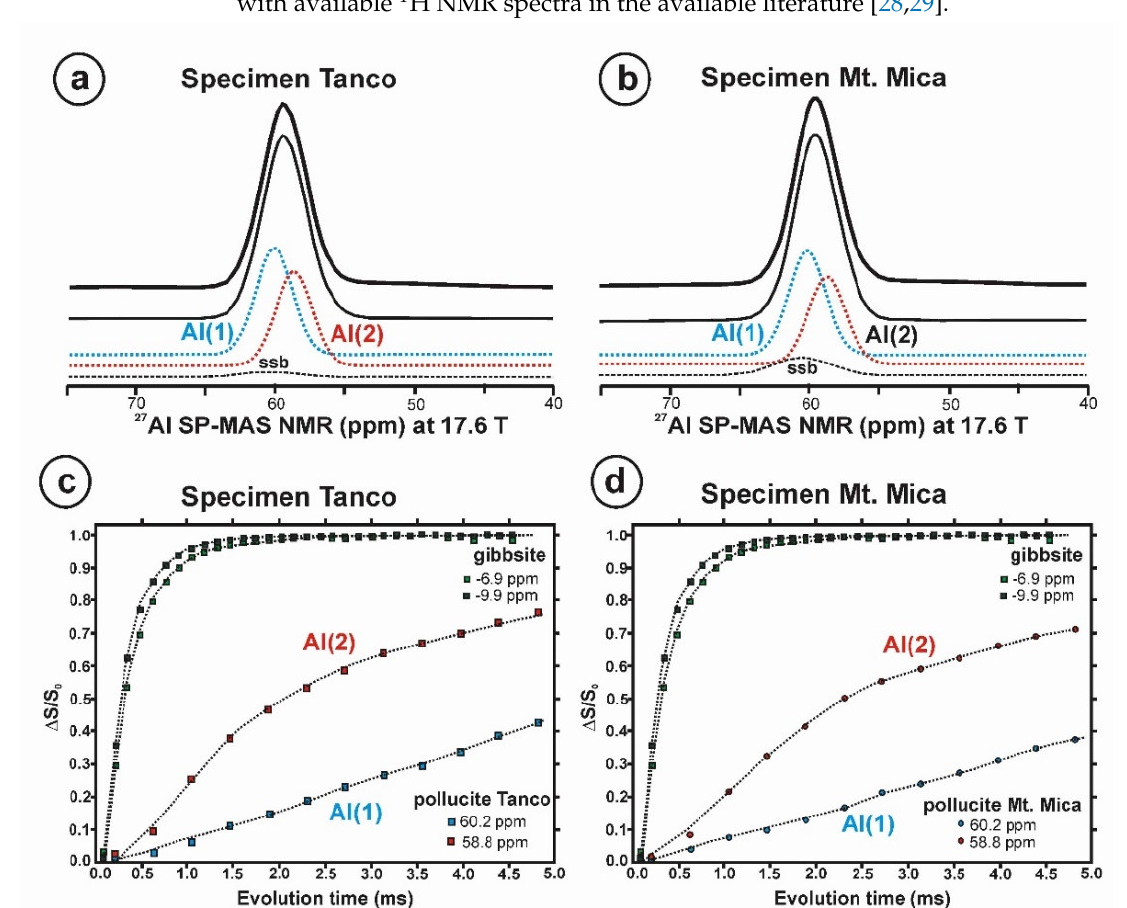
Figure 6. ( a , b ) Single pulse 27 Al spectra of the specimens Tanco and Mt. Mica at 17.6 T, showing a deconvolution of the experimental profile by two Gaussian curves at 60.2 ppm and 58.8 ppm, in addition to the spinning side band from the 3/2 transition. ( c , d ) 27 Al{ 1 H} Dipolar evolutions of the two pollucite specimens in comparison with the same behaviour in the two octahedral sites occupied by Al atoms in gibbsite Al(OH) 3 at 17.6 T ( ∆ S/S 0 where ∆ S = (S 0 − S f ) with S f and S o signals obtained with and without the π pulses on the 1 H. The areas of the two signals at 60.2 ppm and 58.8 ppm in specimen Mt. Mica are 53.9% and 46.1%, respectively, whereas in specimen Tanco they are 50.6% and 49.4%.